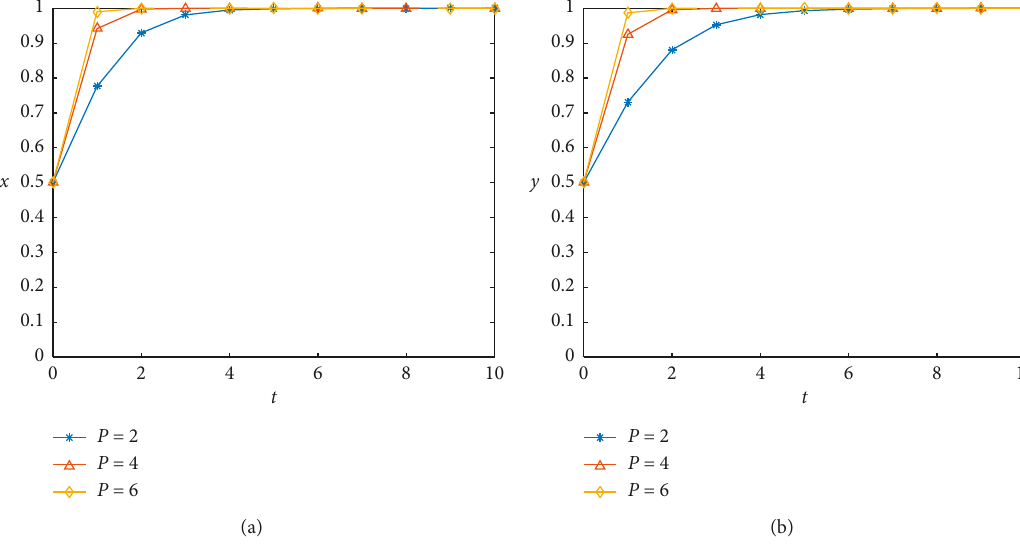
Figure 10: Influences of government penalty P on the evolutionary results ( P � 2 , 4 , 6 ( > 1 )